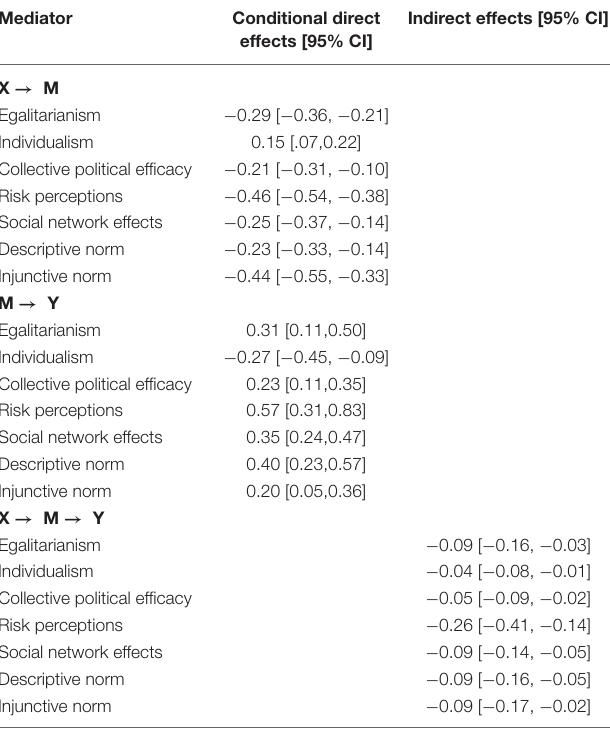
TABLE 4 | Significant mediators of odds of having contacted a government official in the past 12 months.